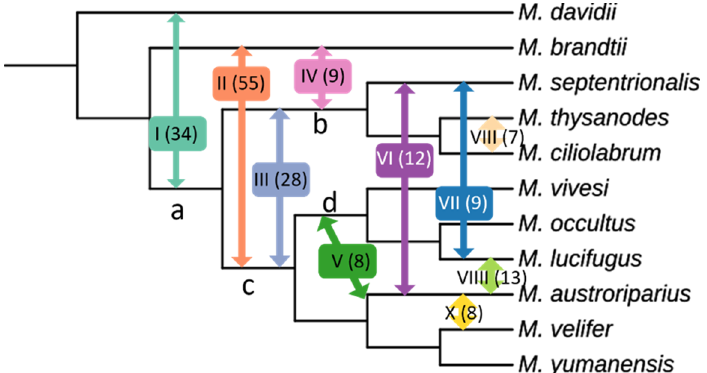
Figure 5. Proposed Introgression Pathways identified using quartet asymmetry tests. A total of 83 quartets indicated significant deviation from expectations under ILS. Pathways are identified by roman numerals with number of quartets supporting in parentheses.